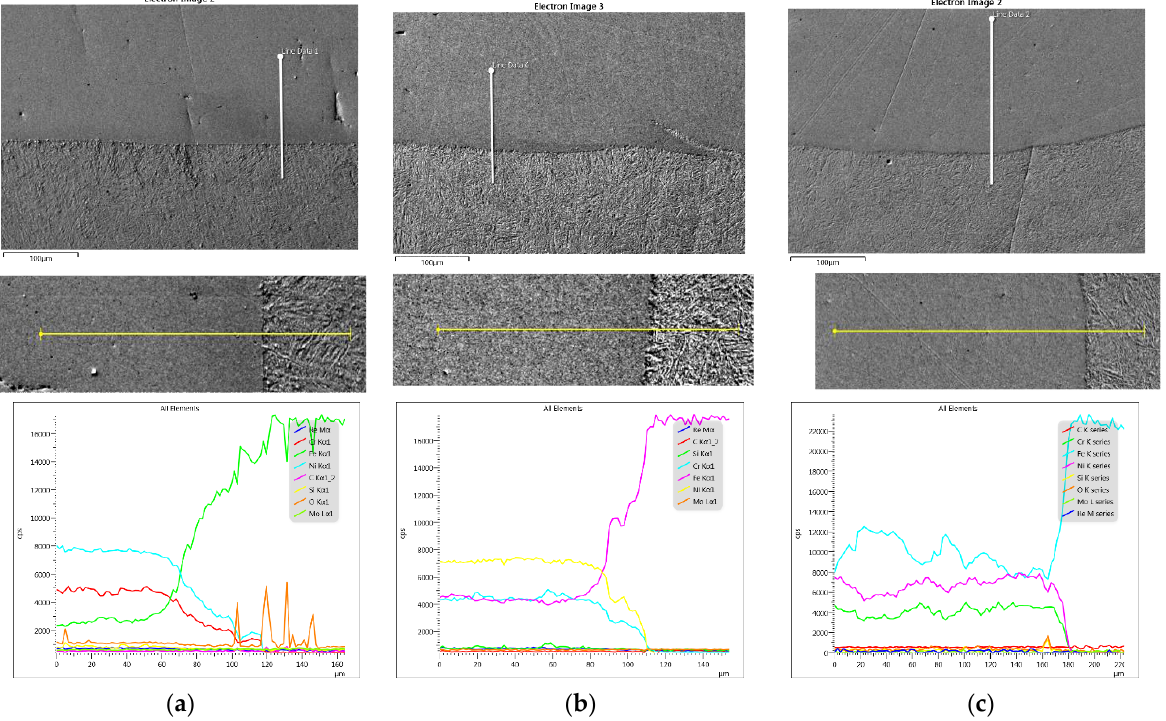
Figure 10. Linear element distributions in the cross section perpendicular to the fusion line of the laser power of ( a ) 2100, ( b ) 2400, ( c ) 2700 W.